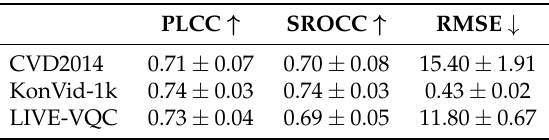
Figure 7. Model trained for image quality assessment to be used as alternative in the Extractor-Q. Table 6. Mean PLCC, SROCC, and RMSE across 100 train-val-test combinations on the four considered databases by replacing the CNN pre-trained for quality attributes with a model trained for image quality